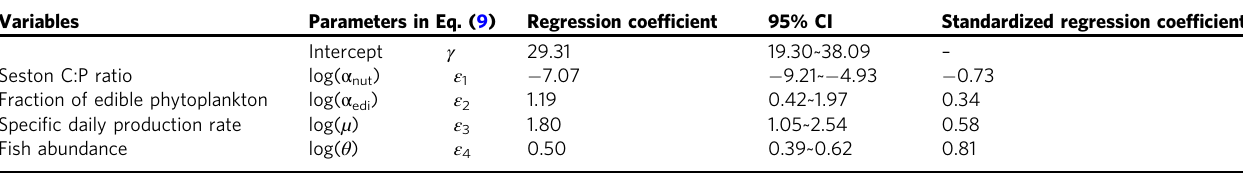
The regression coef fi cient for each independent variable in the multiple regression analysis ( n = 8 treatments in two ponds, R 2 = 0.95, p <0.05). 95% con fi dence intervals estimated by bootstrapping procedure ( n = 1999), and standardized regression coef fi cients for each variable are